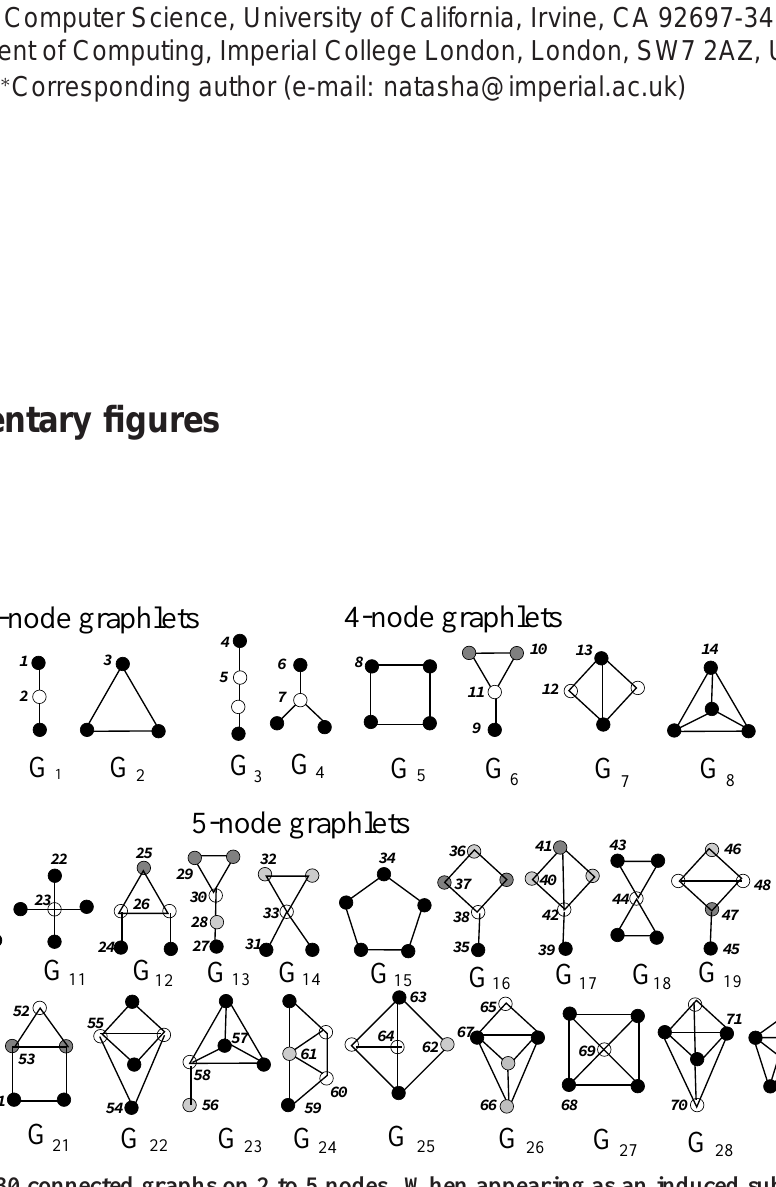
Figure S1: All 30 connected graphs on 2 to 5 nodes. When appearing as an induced subgraph of a larger graph, we call them graphlets . They contain 73 topologically unique node types, called “automorphism orbits,” numerated from 0 to 72. In a particular graphlet, nodes belonging to the same orbit are of the same shade. Graphlet G 0 is just an edge, and the degree of a node historically defines how many edges it touches. We generalize the degree to a 73-component “graphlet degree” vector that counts how many times a node is touched by each particular automorphism orbit. The figure is taken from Prˇzulj et al.